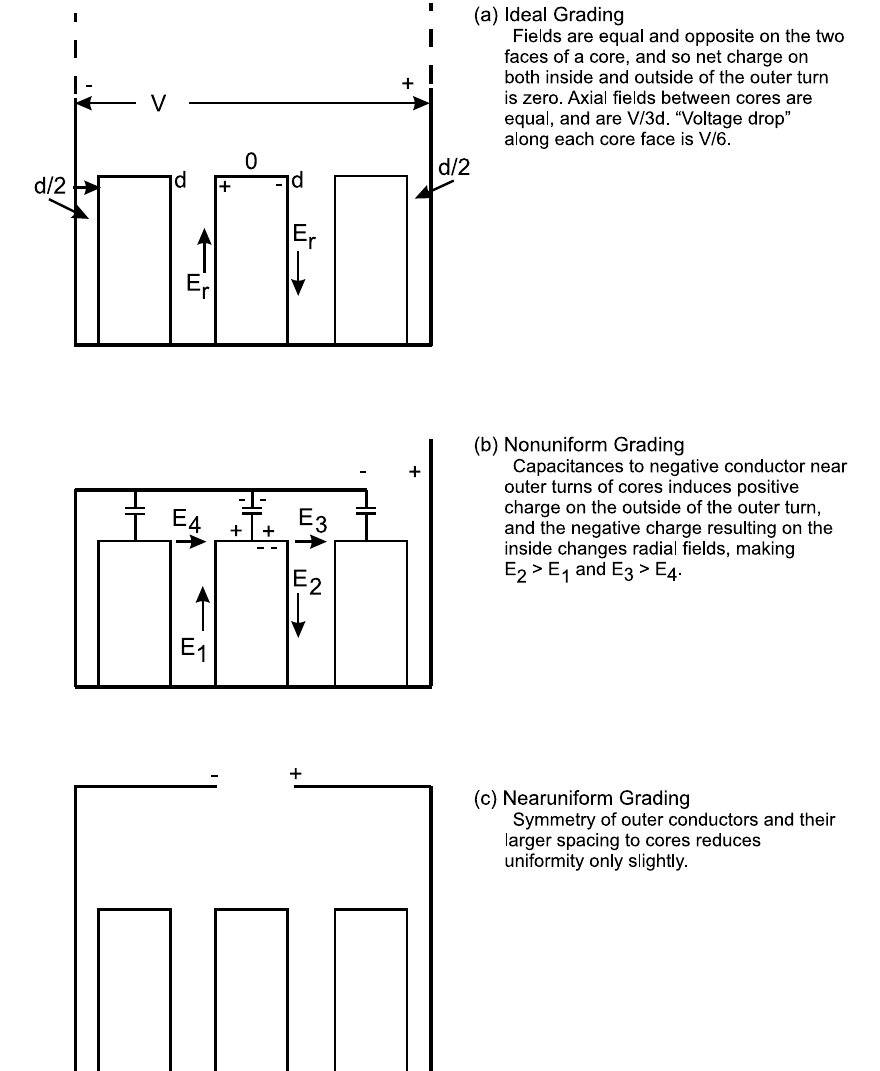
FIG. 26. Effects of nearby conductors on field distribution in a set of three ferromagnetic tape